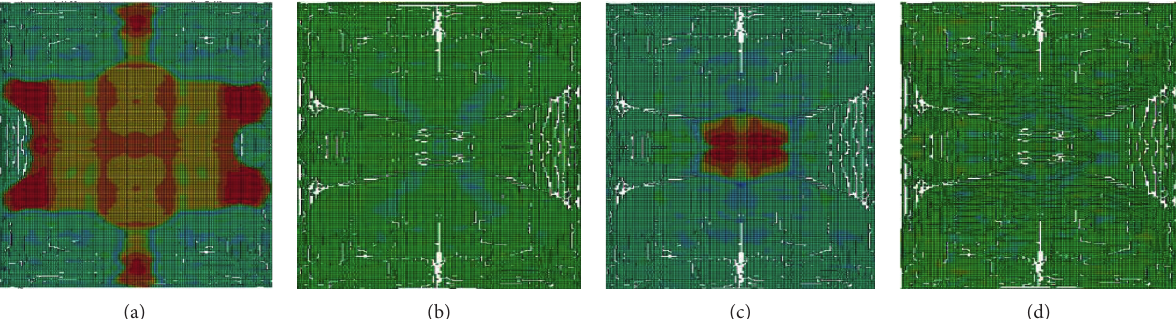
Figure 6: Dynamic damage and failure of thin plate rock mass S-C-S-C under impact load.